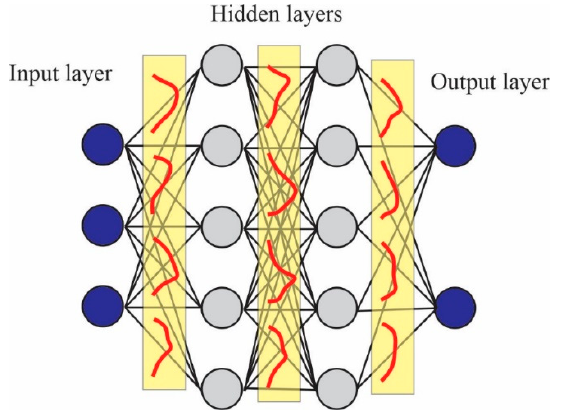
Figure 6. A schematic of a BNN.